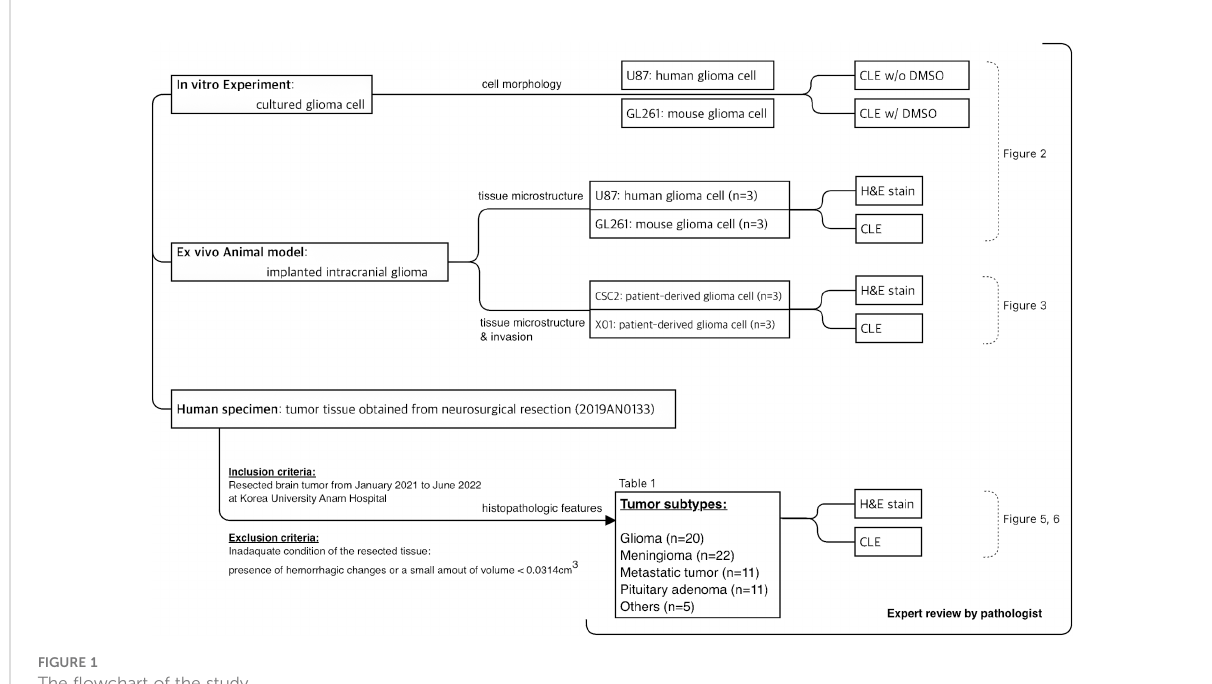
FIGURE 1 The fl owchart of the